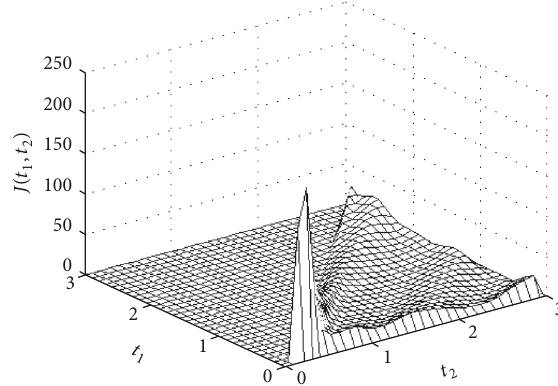
Figure 5: Cost 𝐽 for different (𝑡 1 ,𝑡 2 )